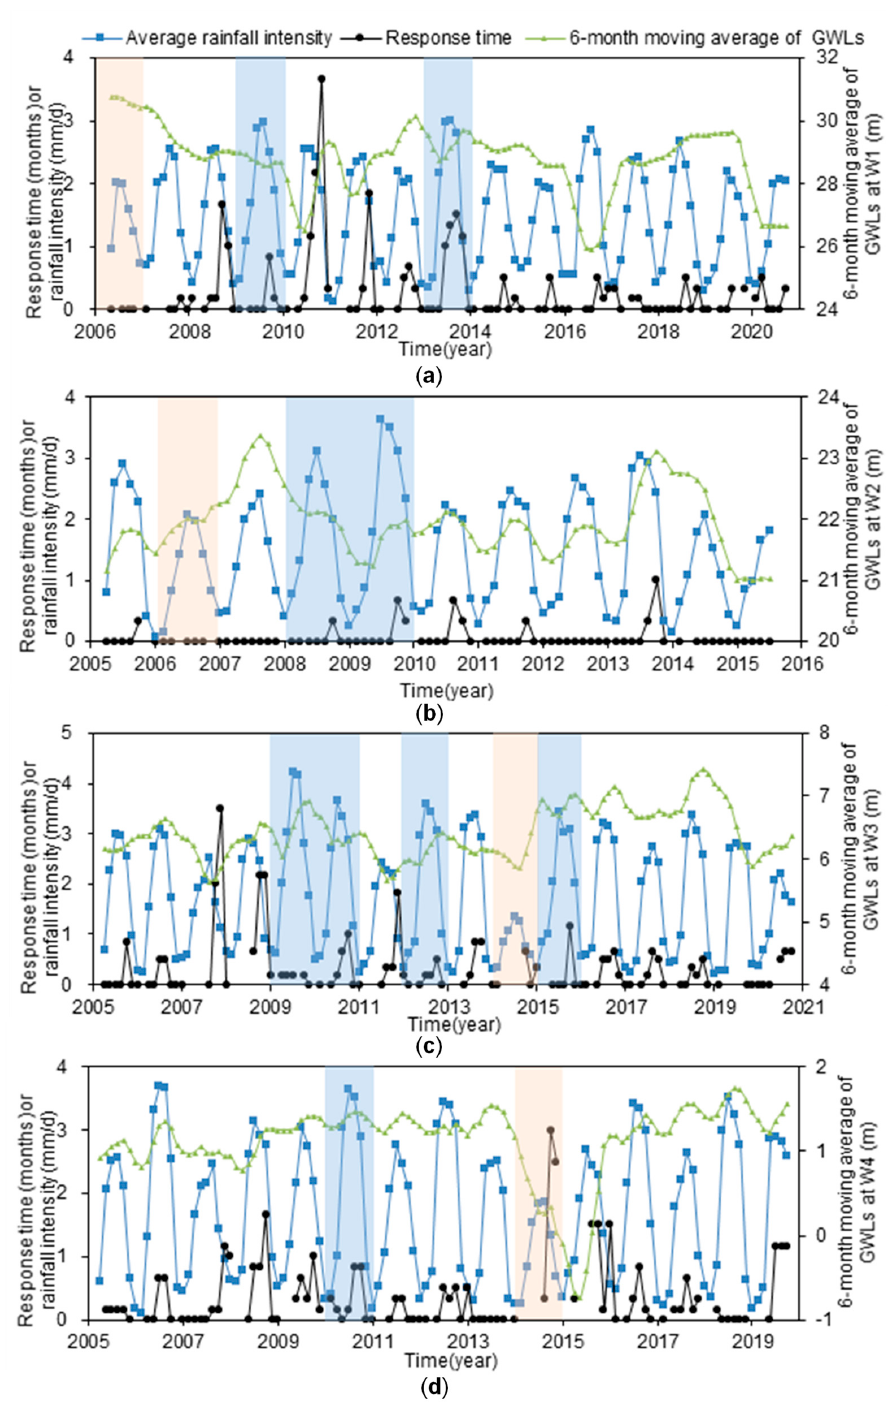
Figure 8. Time series of rainfall intensity, response time, and 6-month moving average of GWLs at ( a ) W1, ( b ) W2, ( c ) W3, and ( d ) W4. The blue and orange bands indicate the wet and dry years, respectively.